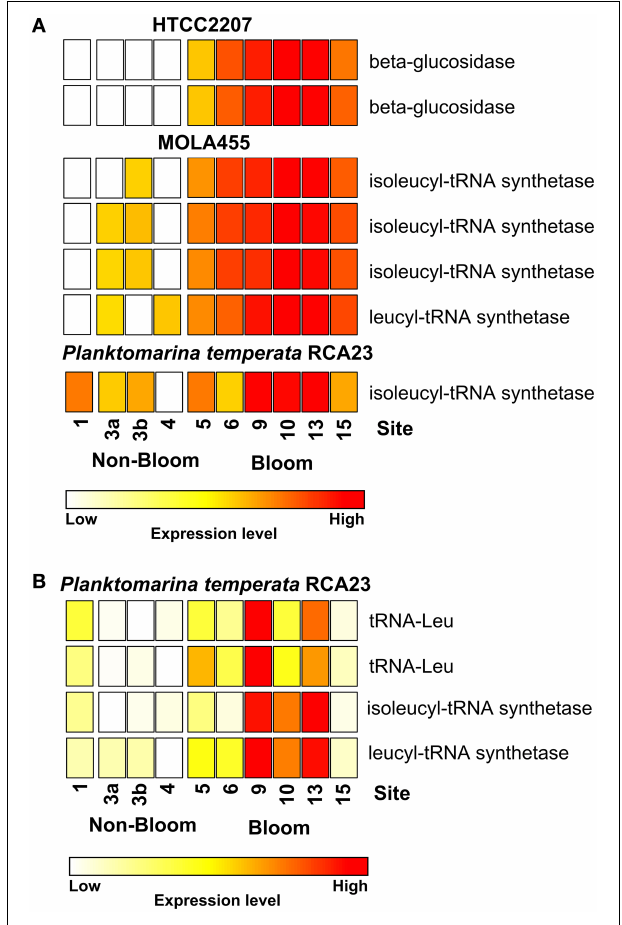
FIGURE 3 | Expression of certain gene involved in leucine/isoleucine incorporation and polymer degradation inside and outside the examined phytoplankton bloom. Data either derives from the mapping on the assembled metagenomic and metatranscriptomic data (A) or from the mapping on reference genomes (B) . Gene expressions levels are log2 transformed and standardized. To obtain only positive values, normalized gene expression values were increased by one prior to log